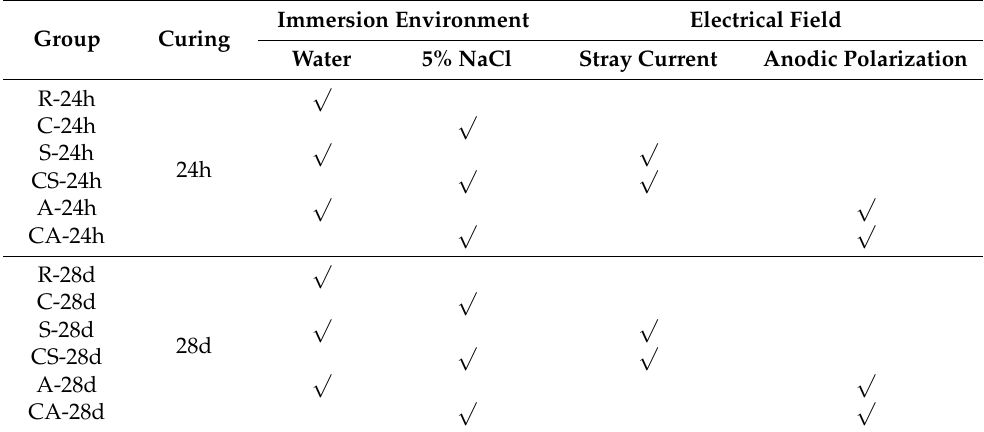
Table 1. Summary of curing and conditioning regimes. Immersion Environment Electrical Field Group Curing Water 5% NaCl Stray Current Anodic